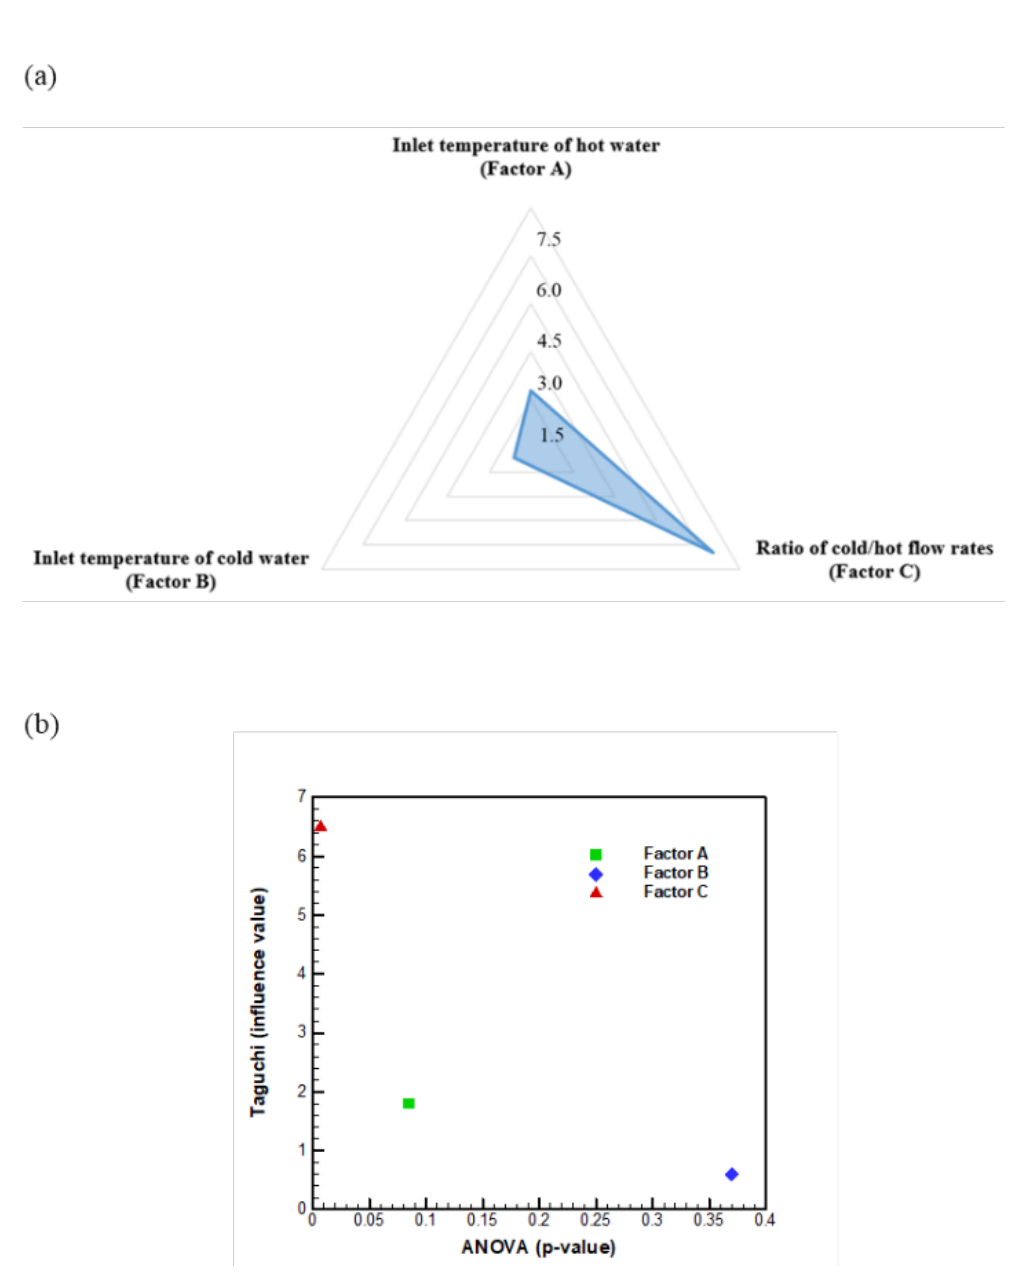
Figure 10. ( a ) Radar chart for Taguchi factor influences; and ( b ) correlation of Taguchi experimental design influence value and ANOVA p -values.